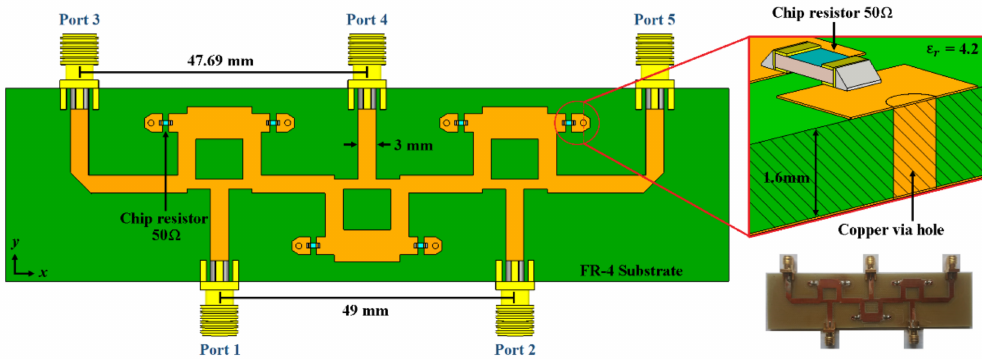
Figure 4. Block of 2 × 3 CORPS feeding network set to a design frequency of 6 GHz.